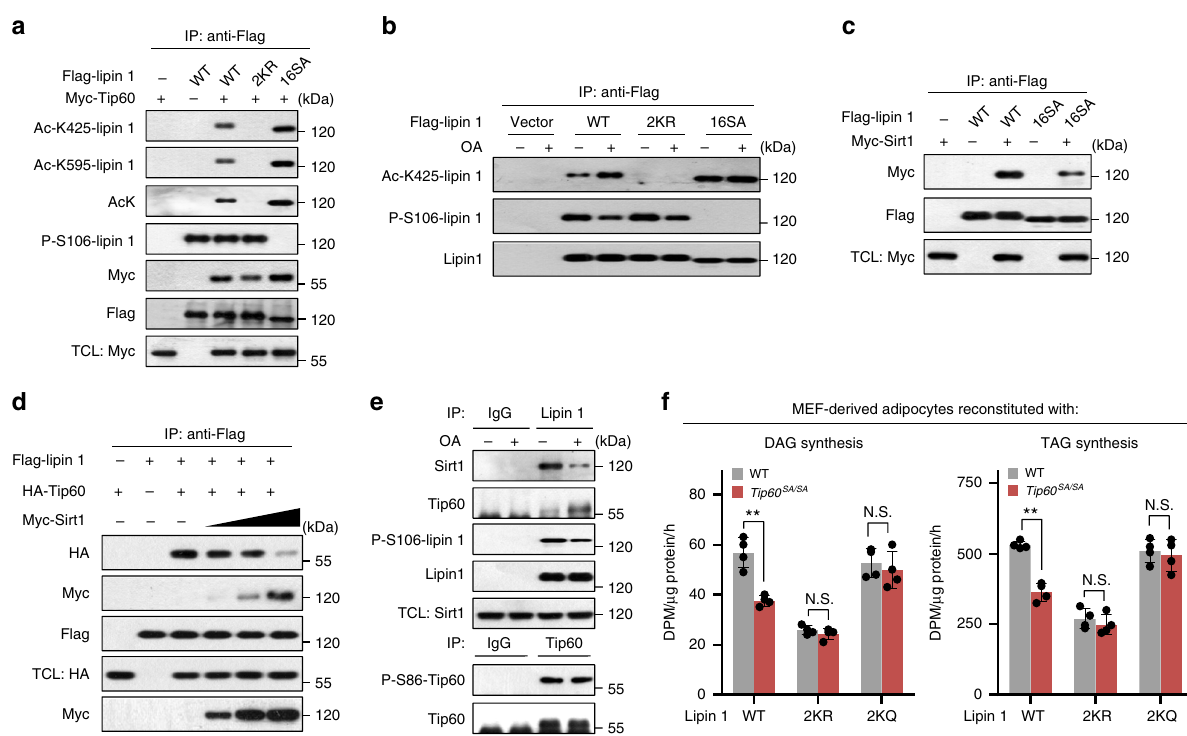
Fig. 6 Lipin 1 acetylation senses fatty acid abundance by its reciprocal association with Sirt1 and Tip60. a Lipin 1 dephosphorylation promotes its acetylation by Tip60. Flag-tagged WT-lipin 1 or 2KR-lipin1 or 16SA-lipin 1 was co-expressed with or without Tip60 in HEK293 cells, immunoprecipitated by antibody to Flag, followed by immunoblotting. b Dephosphorylation of lipin 1 increases its acetylation by Tip60. HEK293 cells transfected with vector, WT-lipin 1 or 2KR-lipin 1 or 16SA-lipin 1 (phosphorylation-defective) were treated with or without OA for 3 h, immunoprecipitated with antibody to Flag and immunoblotted as indicated. c Dephosphorylation of lipin 1 attenuates its association with Sirt1. HEK293T cells were transfected with Flag-lipin 1 and Myc- Sirt1, immunoprecipitated with antibody to Flag and immunoblotted as indicated. d Tip60 and Sirt1 compete with each other in the interaction with lipin 1. HEK293T cells were transfected with Flag-lipin 1, HA-Tip60 and varied amounts of Myc-Sirt1, immunoprecipitated with antibody to Flag and immunoblotted as indicated. e Interaction of endogenous Tip60 and Sirt1 with lipin 1. Lysates of 3T3-L1 adipocytes treated with or without OA for 3 h were immunoprecipitated by antibody to lipin 1 or Tip60 and analyzed by immunoblotting. f TAG/DAG production rates of WT or Tip60 SA/SA adipocytes expressing shRNA targeting Lpin1 with reintroduction of WT-lipin 1, acetylation-defective (2KR) or acetylated mimetic (2KQ) mutant of lipin 1 ( n = 4 experiments). Error bars denote SEM. Statistical analysis was performed by ANOVA followed by Tukey in f . * P < 0.05; N.S. not signi fi cant. Uncropped blots can be found in Supplementary Fig.